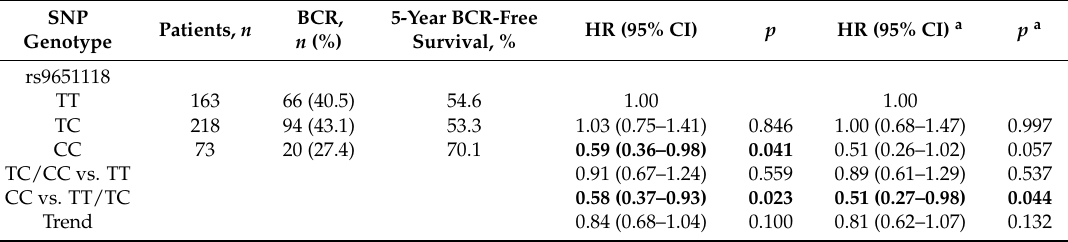
Table 2. Univariate and multivariate analyses of MTHFR rs9651118 and BCR after RP.